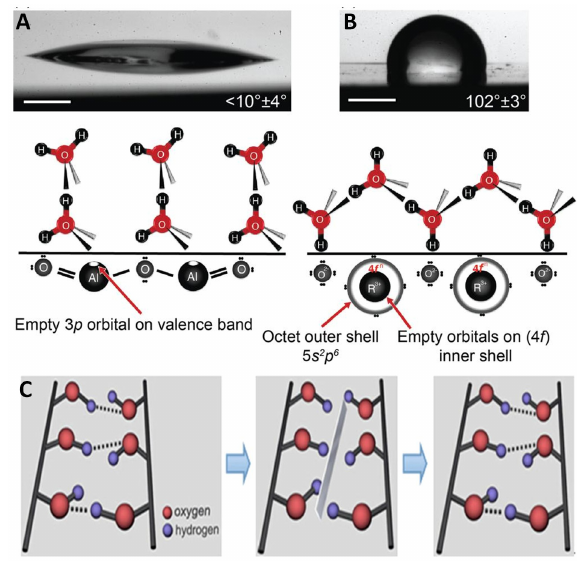
Figure 18. ( A ) and ( B ) Represent wettability and water molecule orientation for an alumina and a neodymia (Rare Earth Oxide) surface, respectively; ( C ) Illustrates the hydrogen-bond modulated self-healing for a polymer thin film designed for anti-fogging applications. Reprinted with permission from Refs. [170,171], respectively. c (cid:13) 2015 AIP Publishing; c (cid:13) 2015 Nature Publishing